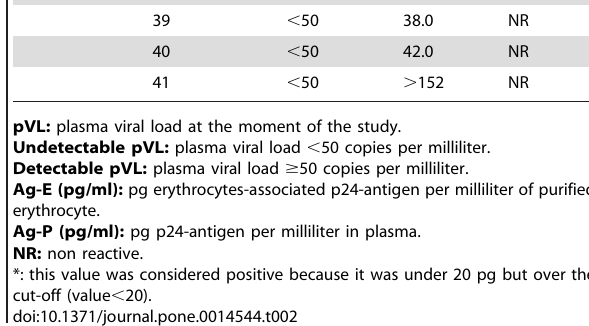
Figure 1. p24-antigen associated to erythrocytes is not related to plasma viral load. Seventy one individuals with detectable plasma